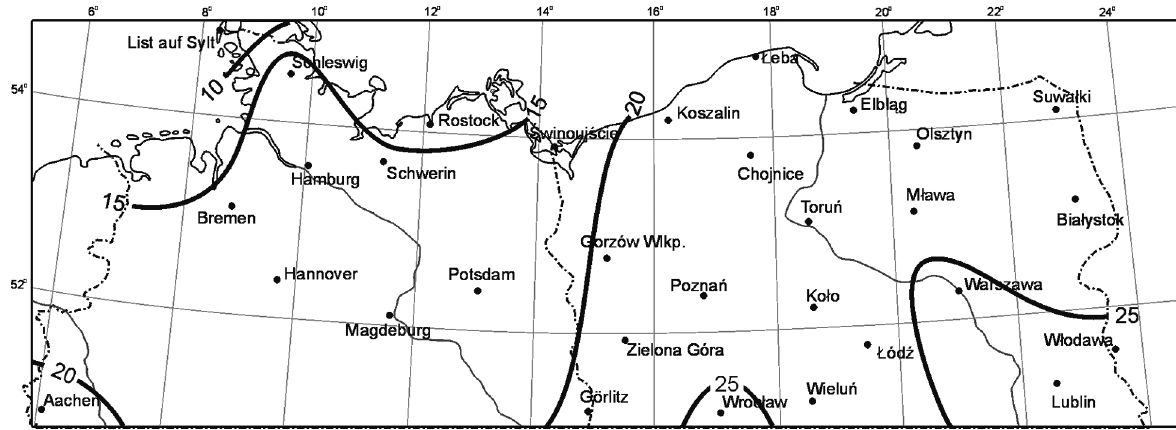
Fig. 1. The average number of days with thunderstorms in the year. Data from the period